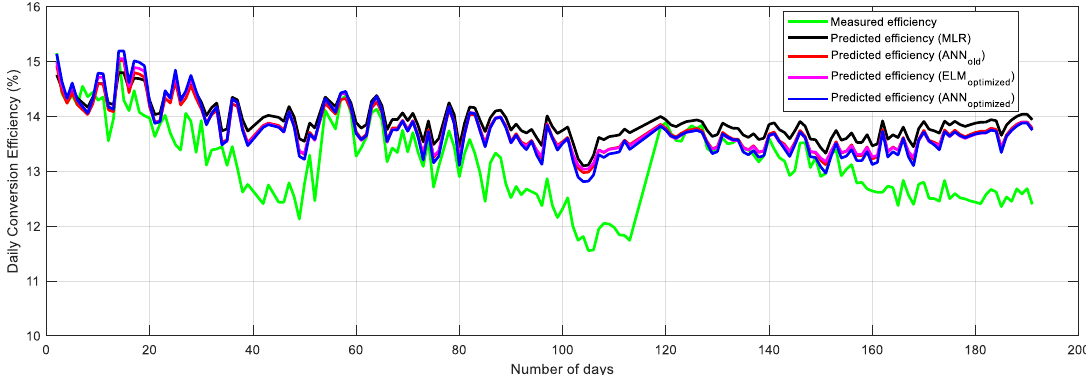
Figure 7. Measured and predicted values of the PV daily system conversion efficiency obtained by the prediction models for the whole study period, without the dust effect.